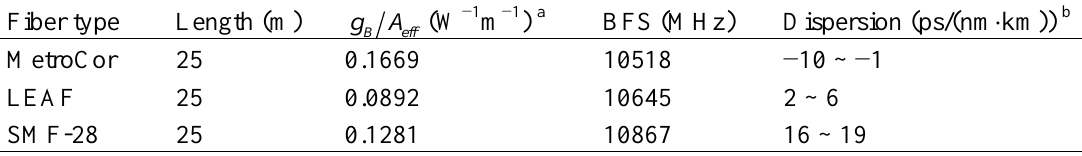
Table 2. Parameters of three types of fibers.